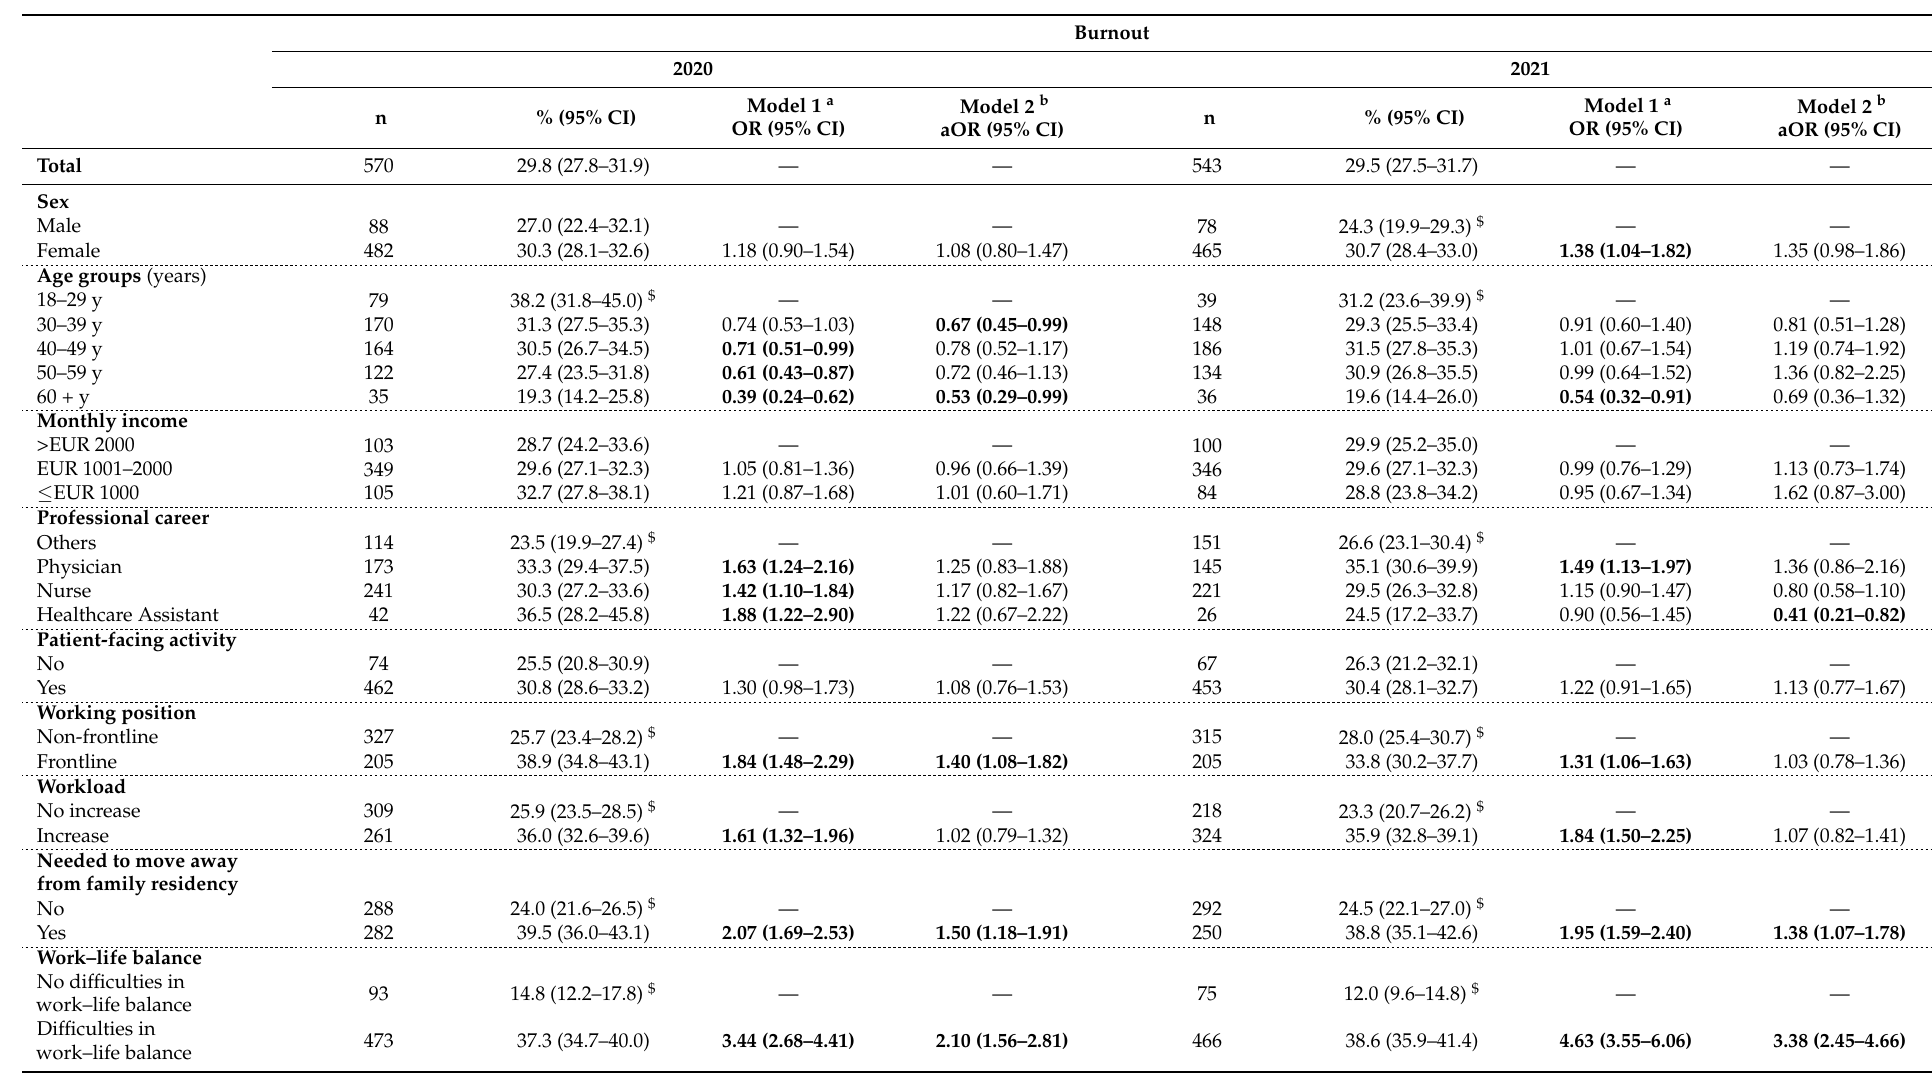
Table 5. Symptoms of burnout among HCPs during the first two years of COVID-19 pandemic in